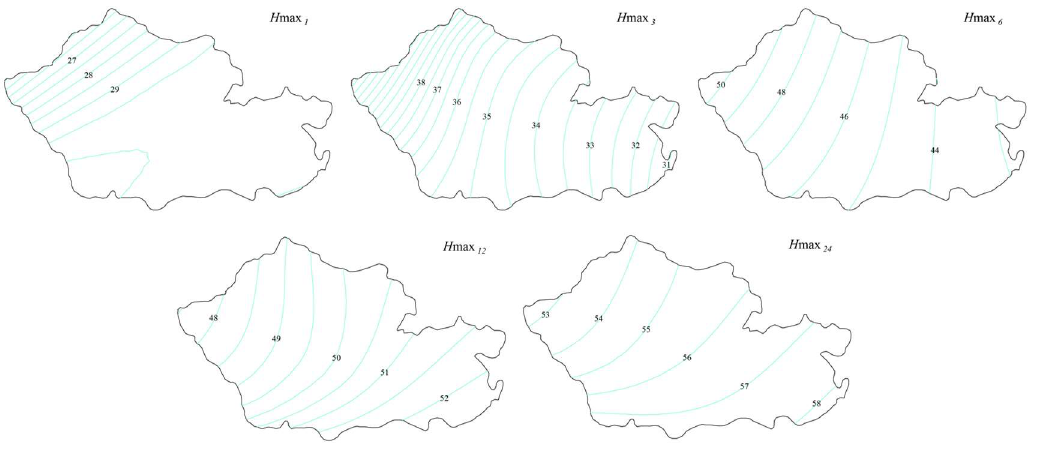
Figure 7. Isohyetal rainfall maps of Zichang County. H max d is the max point rainfall with different durations, mm.